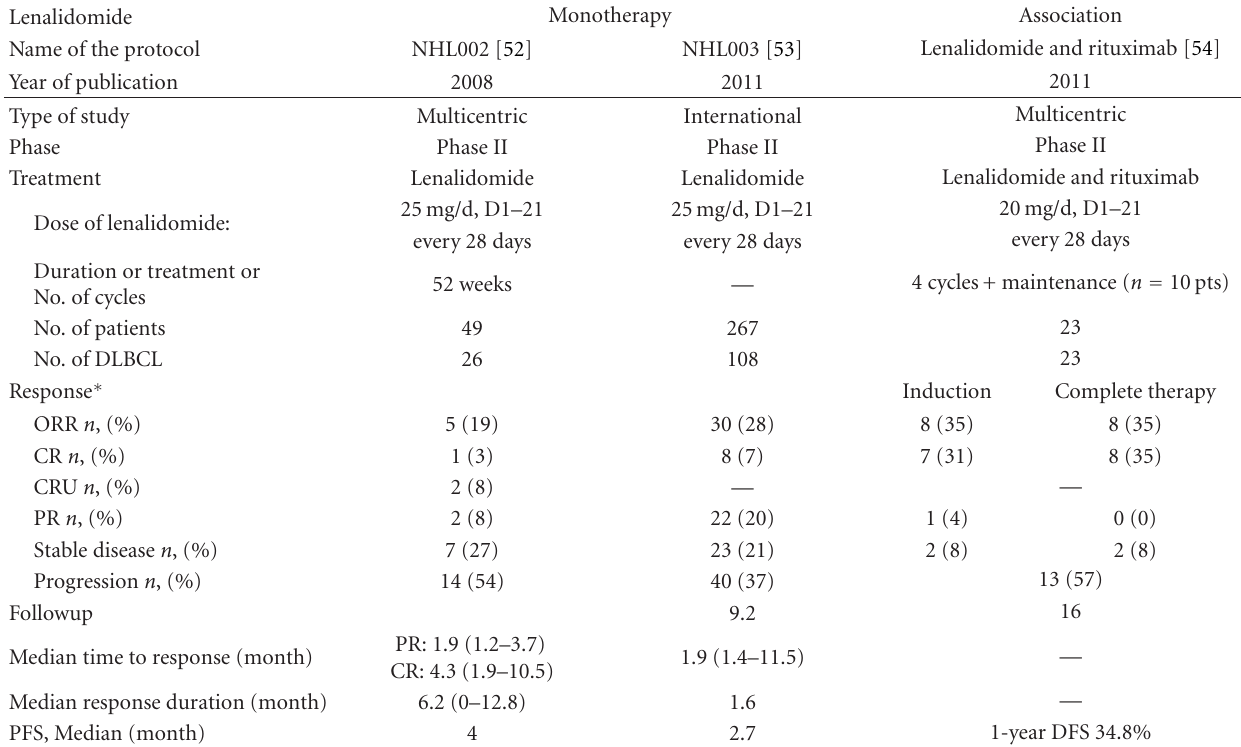
Table 1: Response to Lenalidomide in relapsed/refractory di ff use large B-cell lymphomas. Lenalidomide